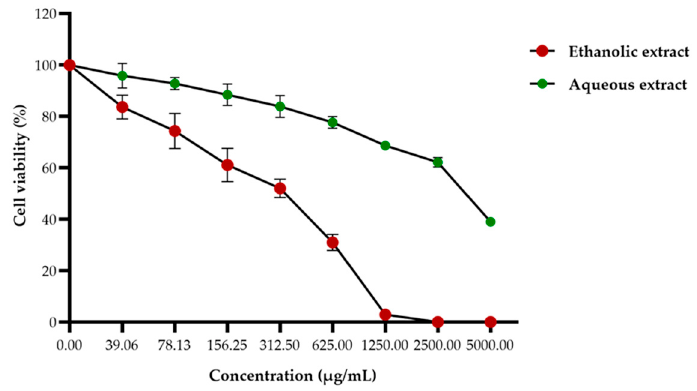
Figure 4. Effect of the ethanolic and aqueous extracts of red jasmine rice on Caco-2 cell viability. The cells were treated with various concentrations of 39.06 to 5000 µ g/mL for 48 h and toxicities of the cells were treated with various concentrations of 39.06 to 5000 µg/mL for 48 h and toxicities of the cells after treatment were investigated by MTT cells after treatment were investigated by MTT assay.